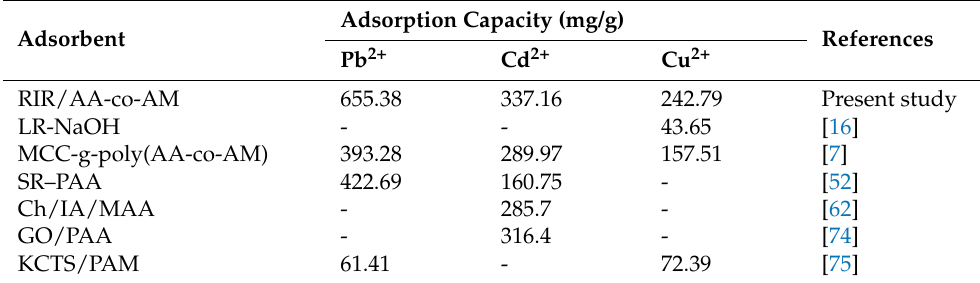
Table 3. Adsorption of heavy metal ions by different adsorbents.